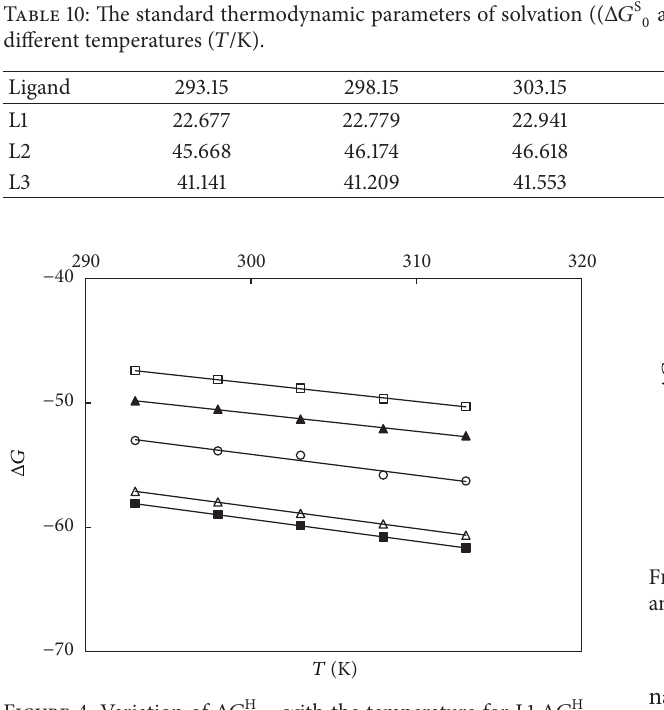
Figure 4: Variation of Δ𝐺 H 𝑛,0 with the temperature for L1 Δ𝐺 H 1,0 ( I ), L2 Δ𝐺 H 1,0 ( 󳵻 ) and Δ𝐺 H 2,0 ( 󳵳 ), L3 Δ𝐺 H 1,0 ( ◼ ), and Δ𝐺 H 2,0 ( ◻ ).